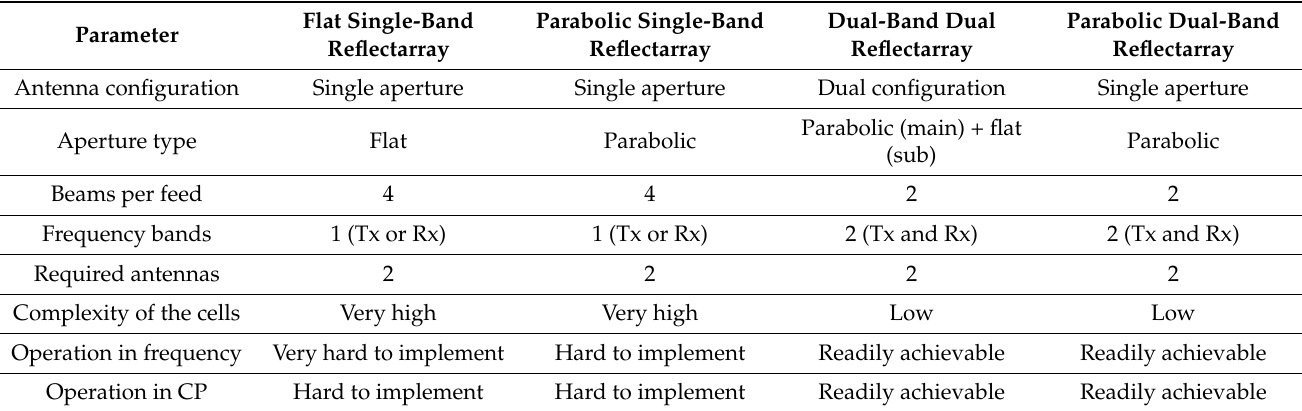
Table 2. Main characteristics of the proposed antenna